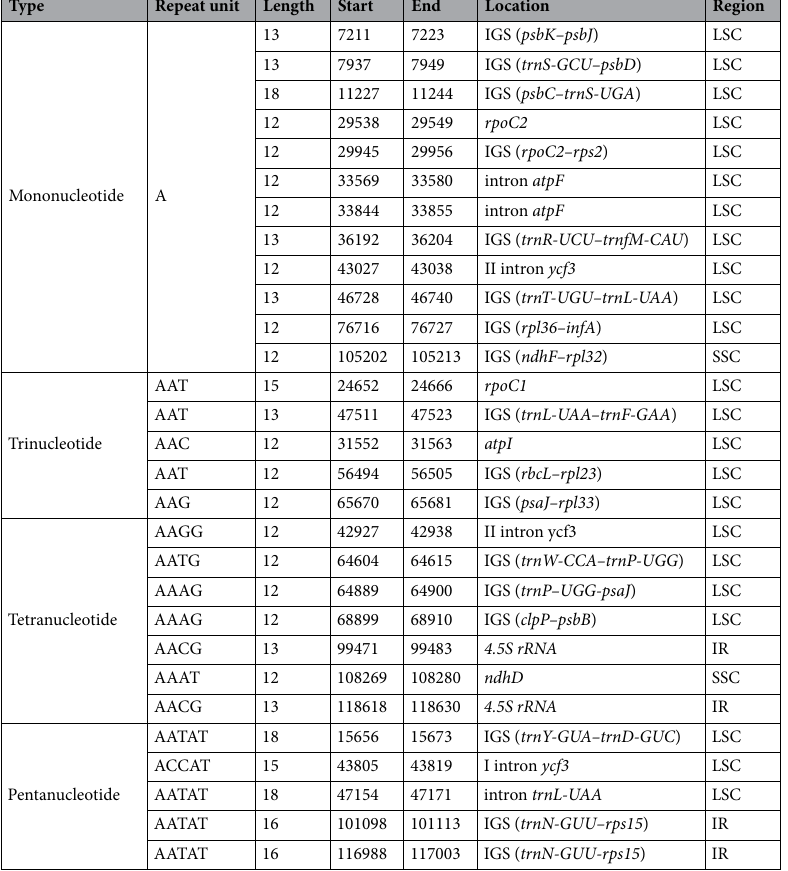
Table 3. Distribution of SSR in the Secale cereale ssp. segetale cp genome. IGS IGS ( psbK-psbJ ) means spacer between psbK and